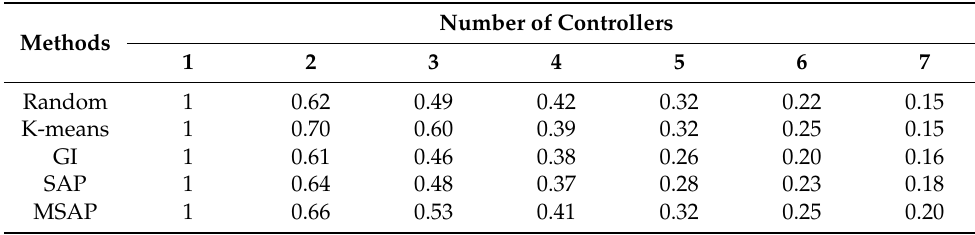
Table 4. Benefit-to-Cost Ratio of Energy